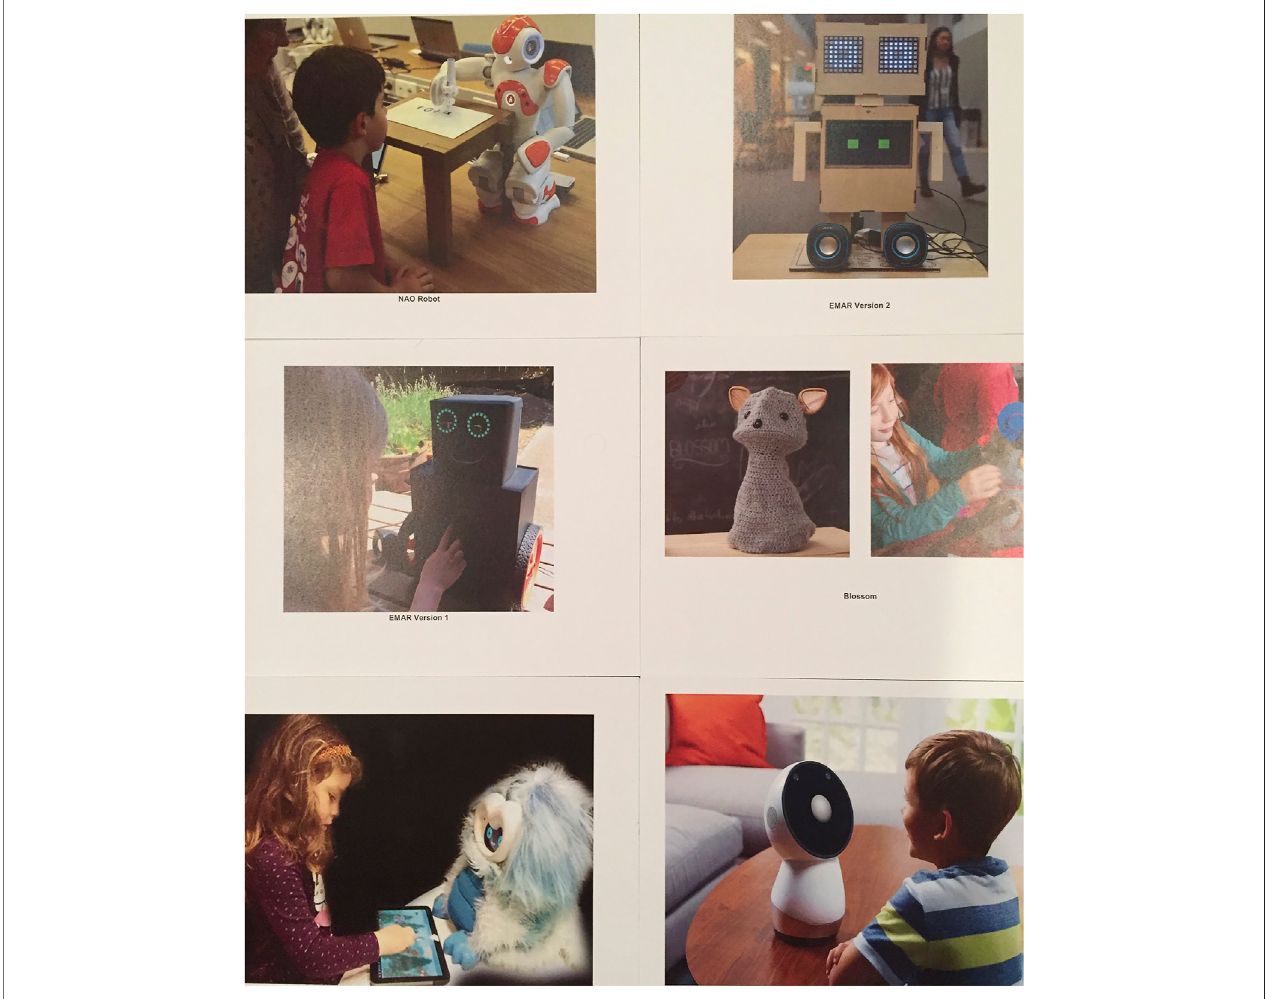
FIGURE 3 | The six robot images shared with